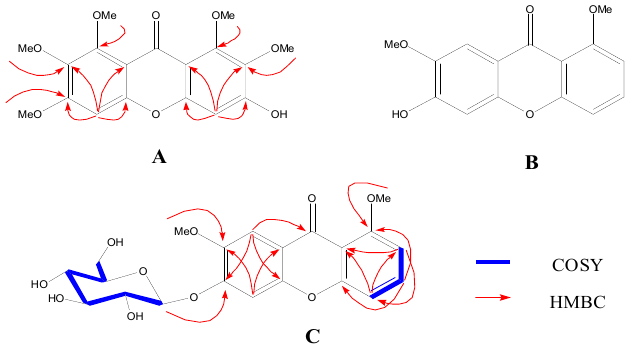
Figure 1. The stucture of compounds A – C from Polygala sibirica.